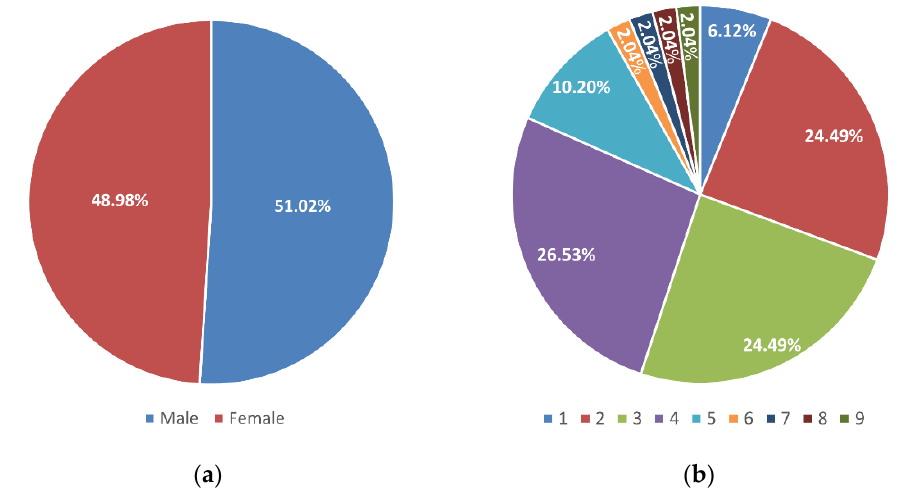
Figure 1. Distribution of samples based on patients’ sex ( a ) and age ( b ).